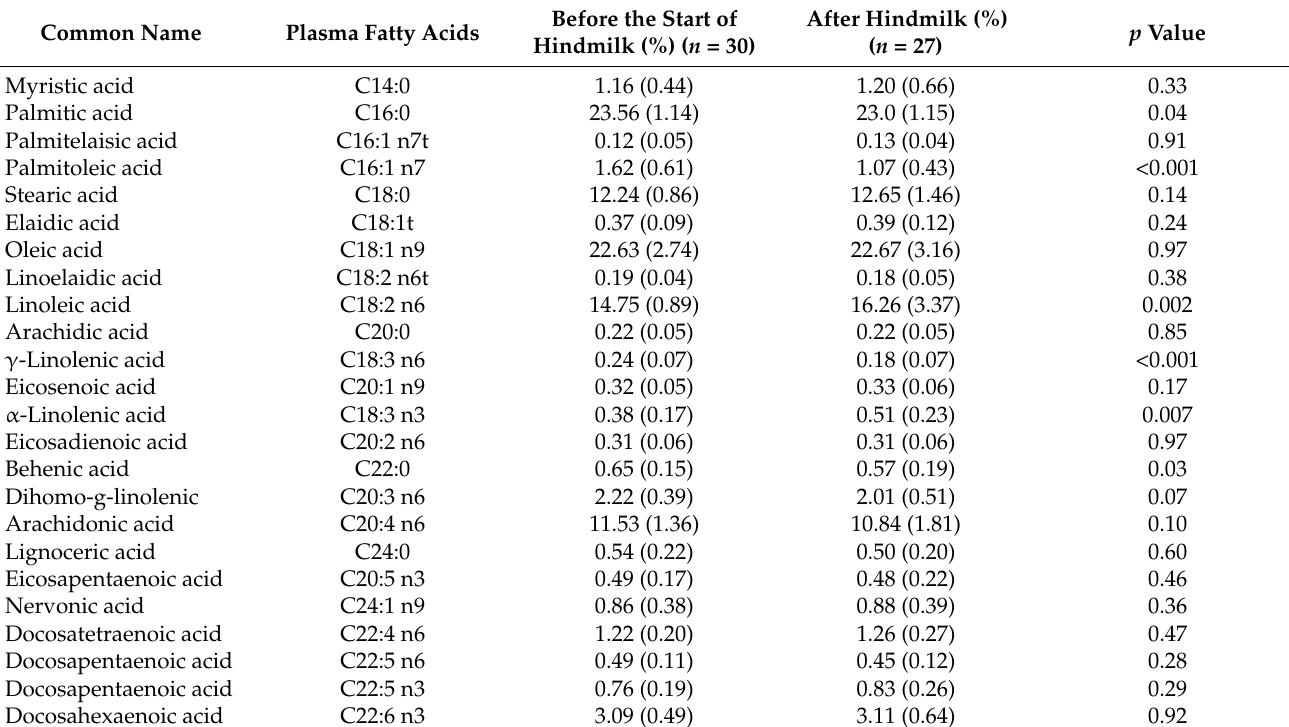
Table 5. Plasma fatty acids proportions before and 2 weeks after feeding